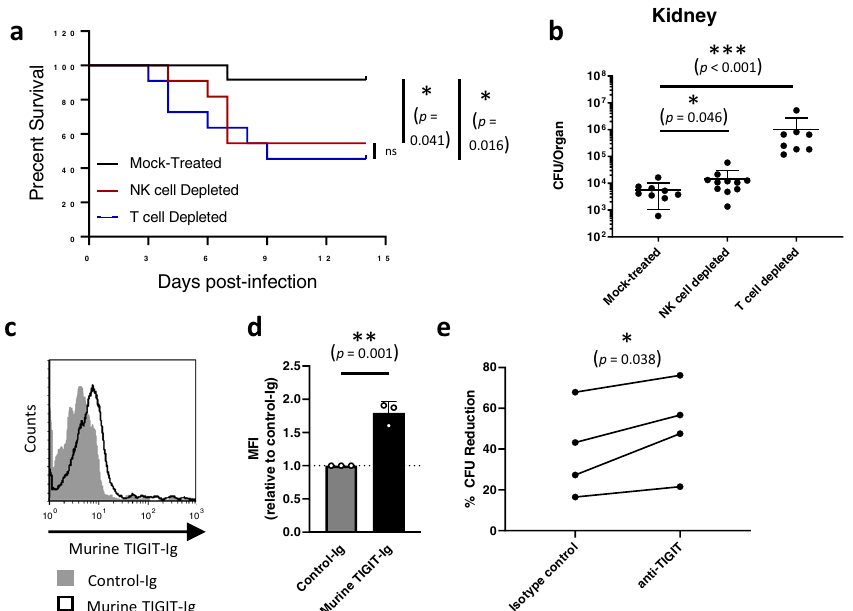
Fig. 5 TIGIT manipulation of NK and T cells by C. albicans is an immune-evasion mechanism in mice. a Survival of C57BL/6 mice infected intravenously with C. albicans cells and depleted for NK cells (red line), T cells (blue line) or mock-depleted (black line). Each line represents 10 – 12 mice from 2 independent experiments. b C. albicans burden in the kidney 48h post I.V. infection of C57BL/6 mice. The mice were depleted for NK cells, T cells or mock-depleted. Kidneys were harvested, processed, and seeded on Sabouraud dextrose agar plates. n = 8 – 11 animals examined over 2 independent experiments. Data are presented as mean values ± SD. c Flow cytometry staining of C. albicans SC5314 yeast cells using Murine TIGIT-Ig (Black empty histogram) or a negative control protein ( fi lled gray histogram). One representative experiment out of 3 is presented. d Quanti fi cation of the results presented in ( c ). n = 3 independent experiments. Data are presented as mean values ± SEM. e Cytotoxicity assay of C. albicans yeast cells using splenic NK cells isolated from mice. The NK